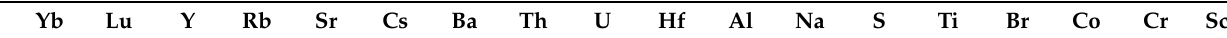
Table 5. Correlation matrix. Bold: p < 0.01; underlined: p <